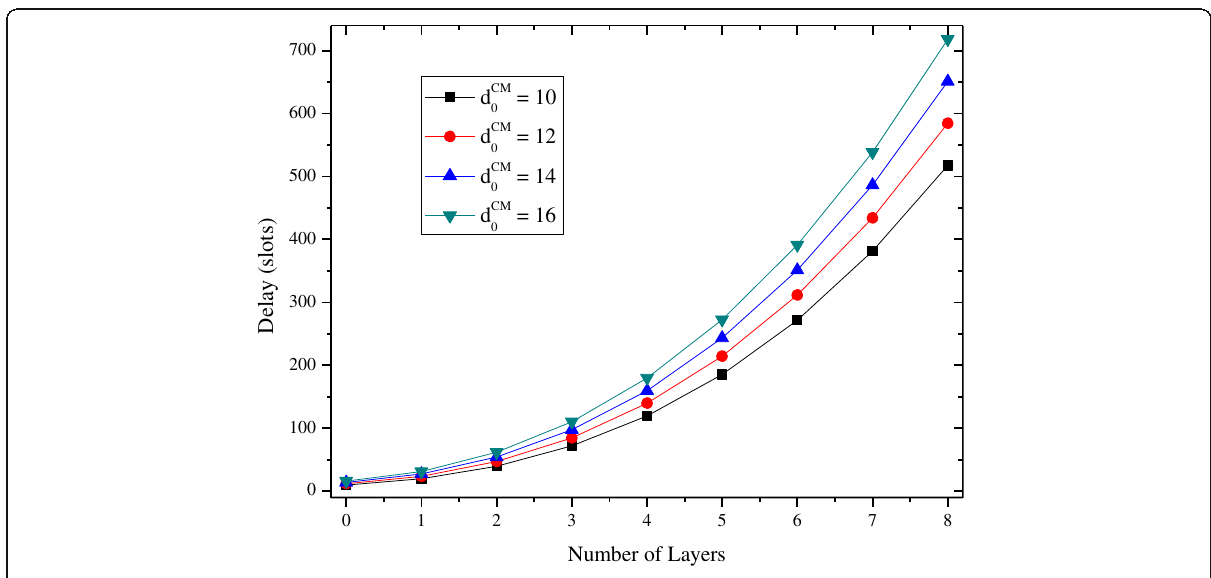
energy consumption. This phenomenon can be under- mainly determines the number stood as the value of d CM 0 of packets received by CH. ¼ 10) and d CH is When d CM takes the same value ( d CM 0 0 different, the total energy consumption is as shown in Fig. 15. The energy consumed by the node decreases as d CH increases. The larger the d CH , the more CM nodes, the smaller the average energy consumption to transfer packets, and ultimately, the smaller the total